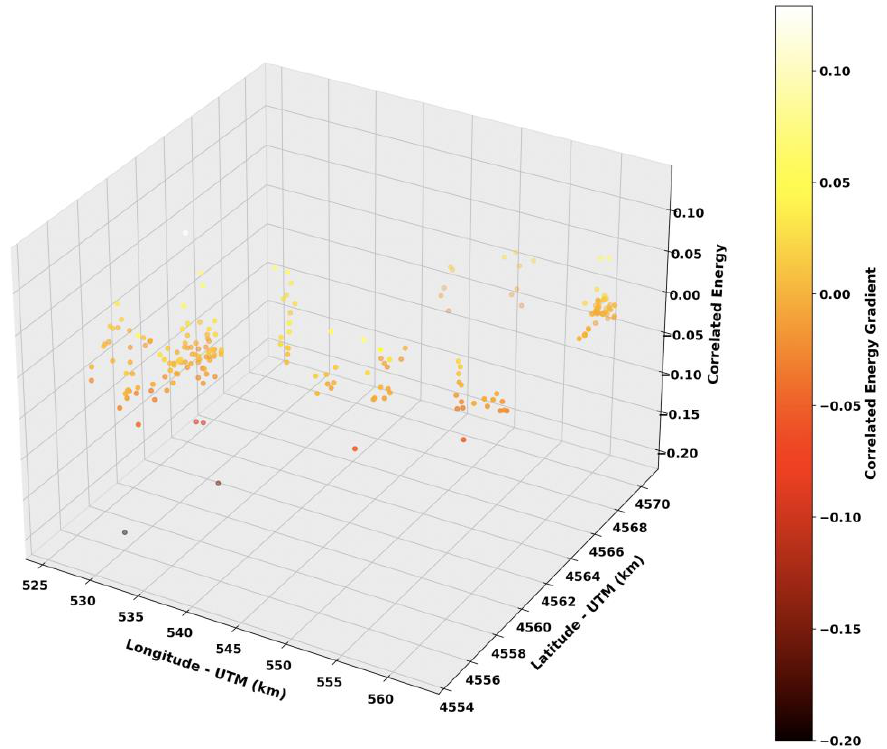
Figure 9. Net energy and geographic location comparison between members.